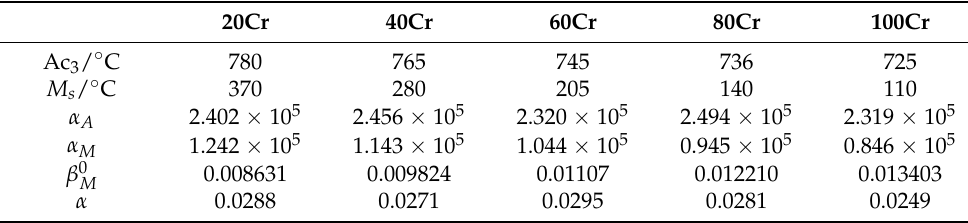
Figure 5. The CCT curves of samples with different carbon contents: ( a ) 20Cr; ( b ) 40Cr; ( c ) 60Cr; ( d ) 80Cr; ( e ) 100Cr (cooling rates: 1–17.2 ◦ C/s, 2–8.6 ◦ C/s, 3–4.3 ◦ C/s, 4–1.72 ◦ C/s, 5–0.86 ◦ C/s, 6–0.28 ◦ C/s, 7–0.14 ◦ C/s and 8–0.06 ◦ C/s; Abbreviation for Microstructure: A—Austenite, B—Bainite, F—Ferrite, P—Pearlite, M—Martensite). Table 2. The parameters obtained from the expansion